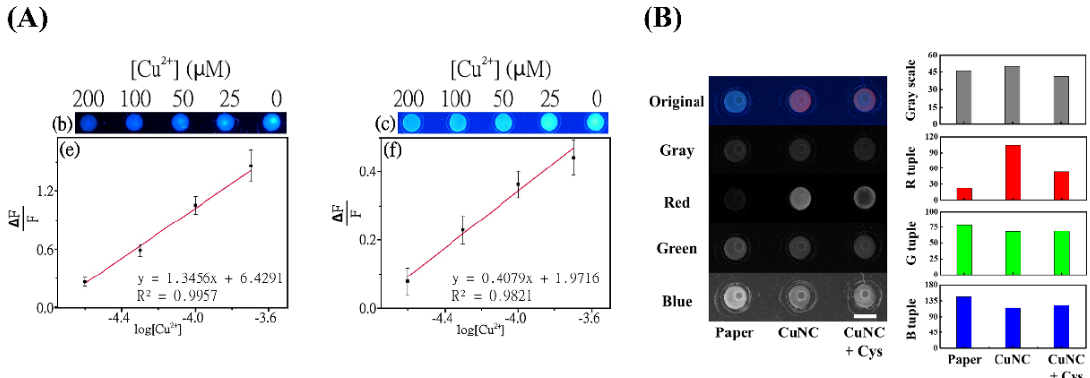
Figure 3. ( A ) The reduced blue fluorescence background from devices made with OPP/PVB lamination films (left) compared to devices made with PET films (right). ( B ) Enhanced device responses from monitoring only the red tuple of images collected from devices utilizing red fluorescence-emitting copper nanoclusters. Adapted with permission from [14,16].